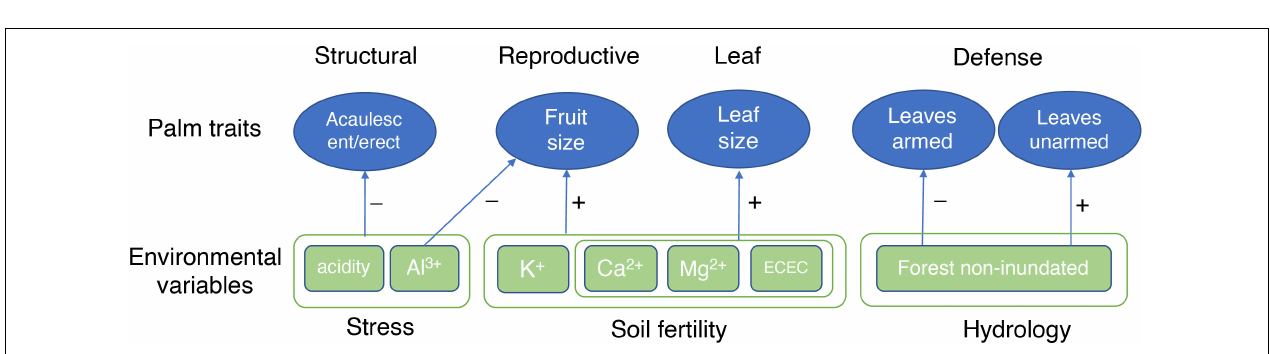
FIGURE 4 | Fourth-corner analysis carried out for functional traits of palm and environmental variables. Colored squares show significant correlations ( P < 0.05) measured by a Pearson correlation coefficient for two quantitative variables, by a Pearson χ 2 and G statistic for two qualitative variables and by a Pseudo- F and Pearson r for one quantitative variable and one qualitative variable. Red, positive correlation and blue, negative correlation. local environmental variables ; FT.inun, inundated forest; FT.nin, non-inundated forest; FT.PrH, premontane hills and FT. WhS, white sand forest. Soil variables : pH, loi, loss-on-ignition; Al, aluminum concentration; K, Potassium concentration; acidity, exchangeable acidity; BS, base saturation; Ca, Calcium concentration; Na, Sodium concentration; P, Phosphorus concentration; ECEC, effective cation exchange capacity, and Mg, Magnesium concentration.